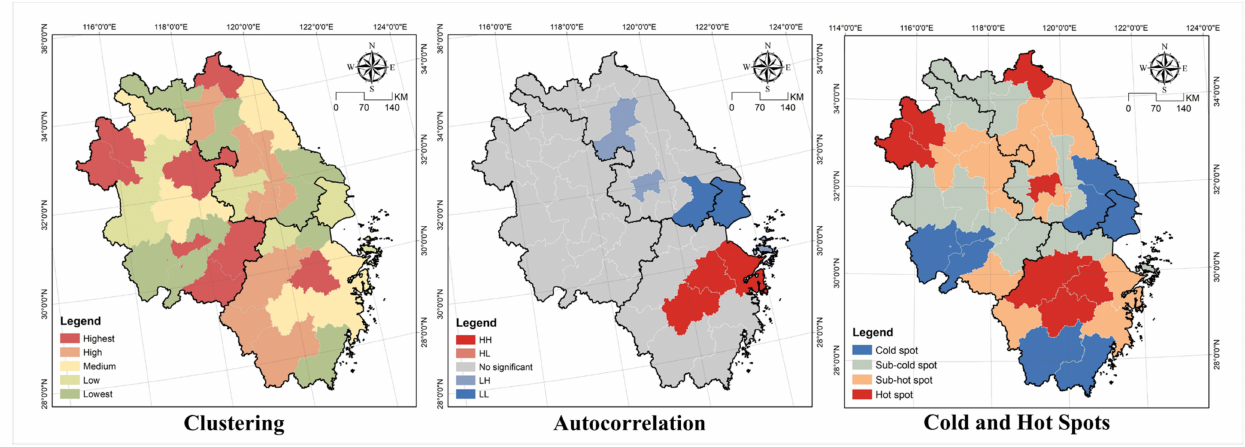
Figure 6. Spatial analysis of the change speed in 2010–2014.